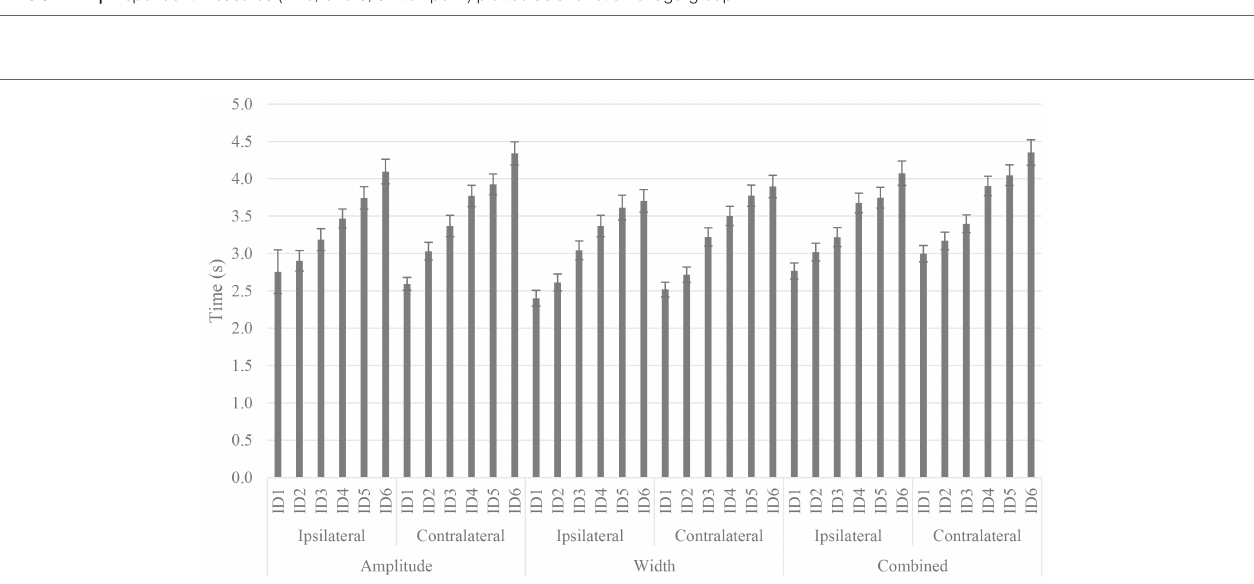
FIGURE 2 | Dependent measures (time, errors, switch point) plotted as a function of